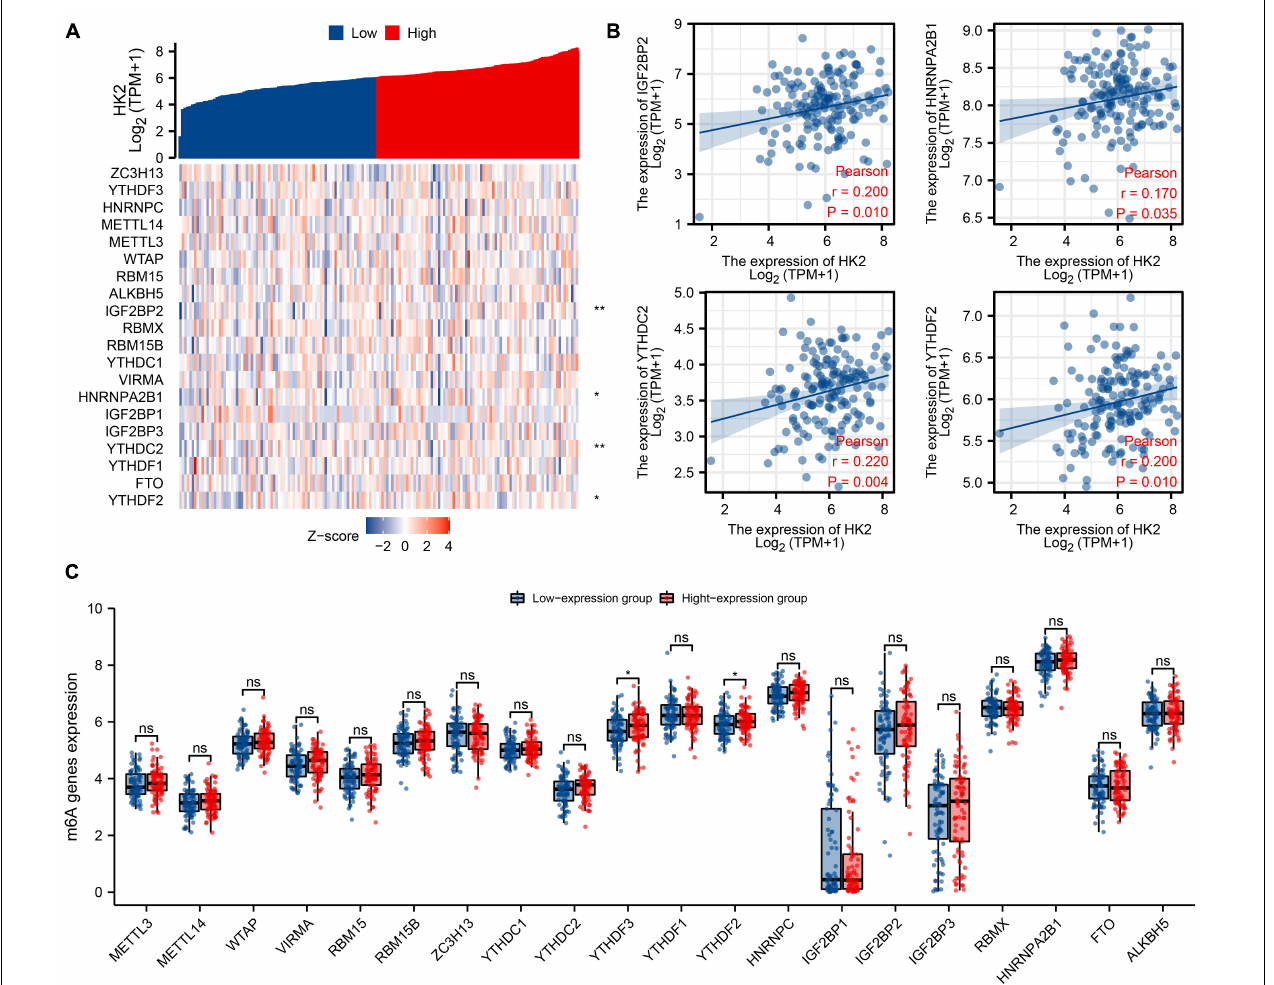
FIGURE 8 | Association of HK2 expression with m6A associated genes in esophageal carcinoma (ESCA). (A) The association between the expression level of HK2 and the expression of m6A associated genes in TCGA ESCA cohort was analyzed. (B) The association between HK2 and m6A associated genes was displayed by scatter plot, include IGF2BP2, HNRNPA2B1, YTHDC2, and YTHDF2. (C) The differential expression of m6A associated genes in the high and low HK2 expression groups was analyzed. * P < 0.05; ** P < 0.01; ns, no